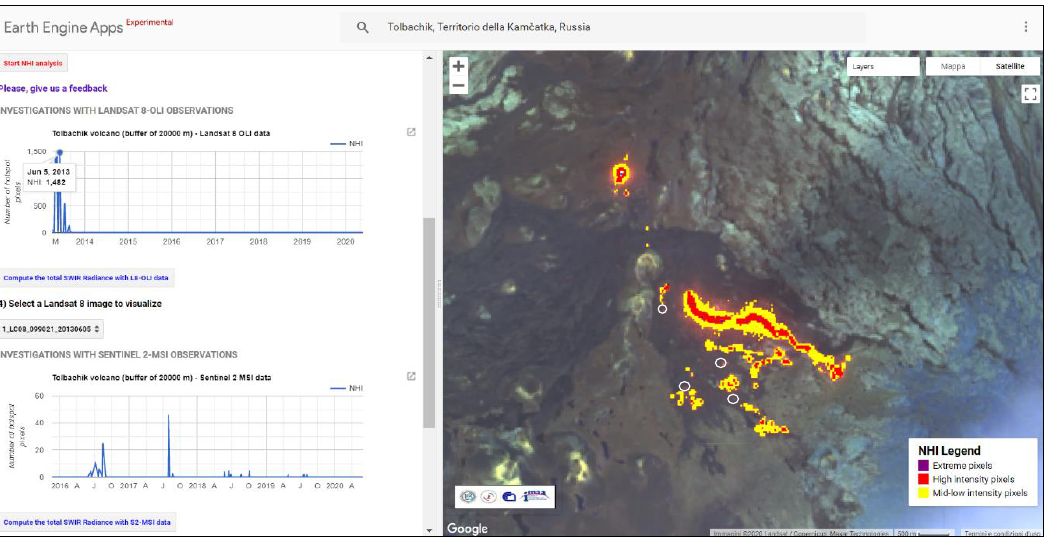
Figure 3. Thermal activity of the Tolbachik (55°49′48″N; 160°19′48″E) (Russia) volcano investigated by means of the NHI tool. On the left, temporal evolution of hot spot pixel number (blue curve) from satellite data of April 2013–May 2020; on the right, thermal anomaly map of 5 June 2013. In background, the OLI RGB (Red = SWIR2; Green = SWIR1; Blue = NIR) image. White circles indicate some of the areas with missed detections. Yellow, red and violet pixels indicate hot spots of a different intensity level (see NHI legend and Table 1).